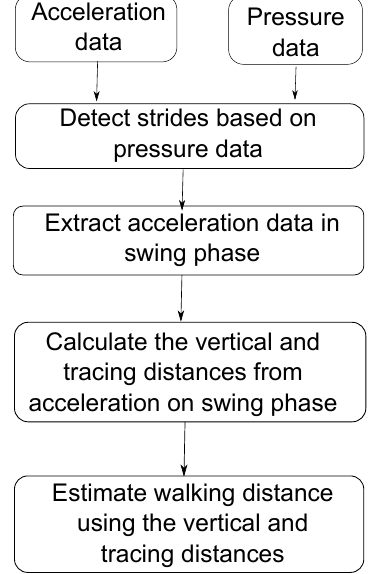
Figure 6. Proposed calculation